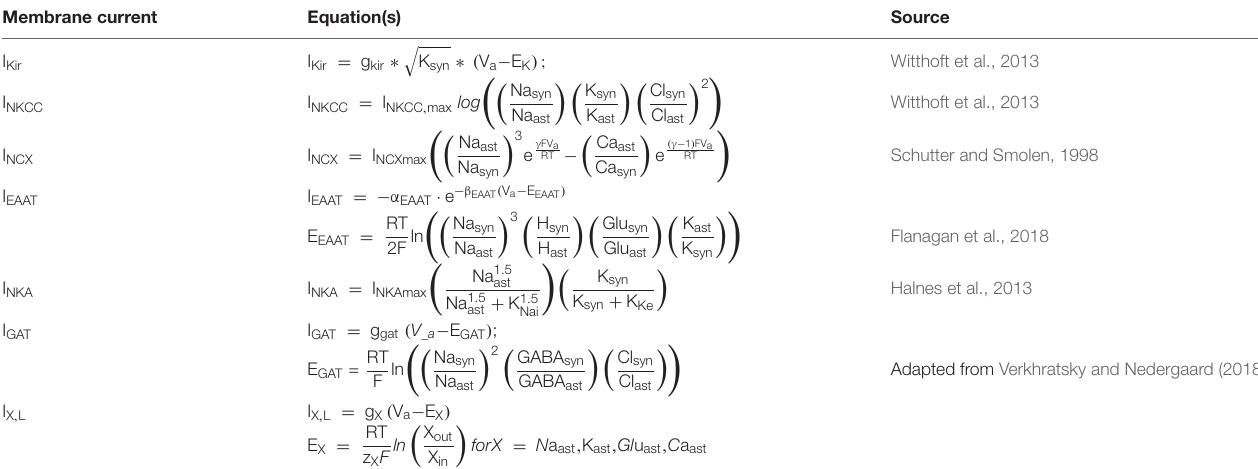
TABLE 4 | Astrocyte membrane transporter equations.